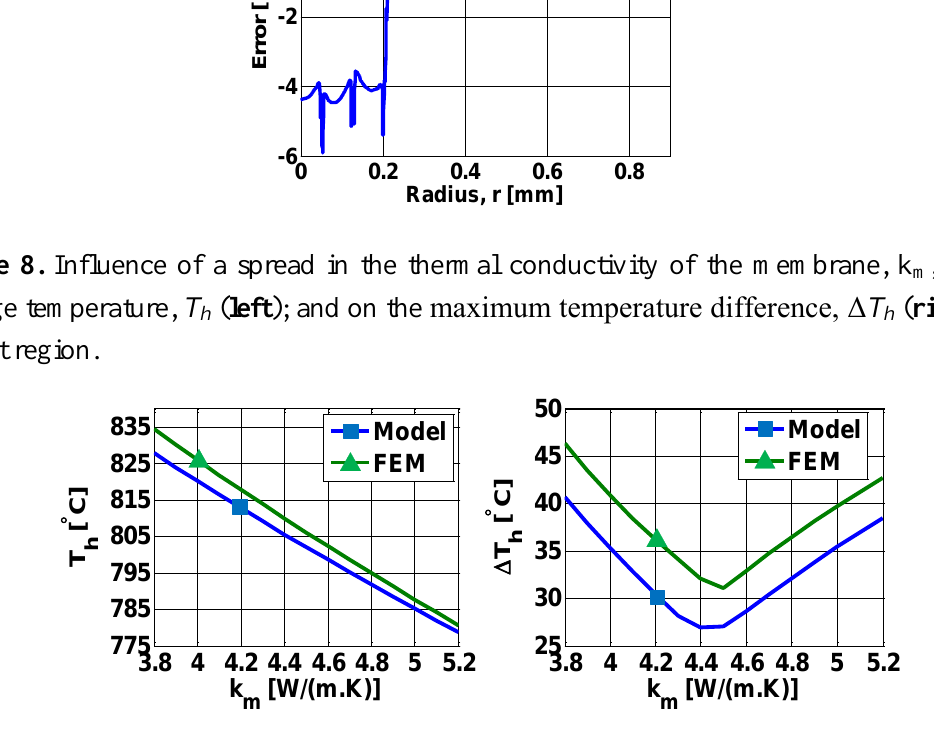
Figure 9. Model results ( a, b ) and FEM results ( c, d ) for the influence of a variation of the bulk temperature, T , and ambient temperature, T b the hot region, T ( a, c ), and maximum temperature difference in the hot region, Δ T h